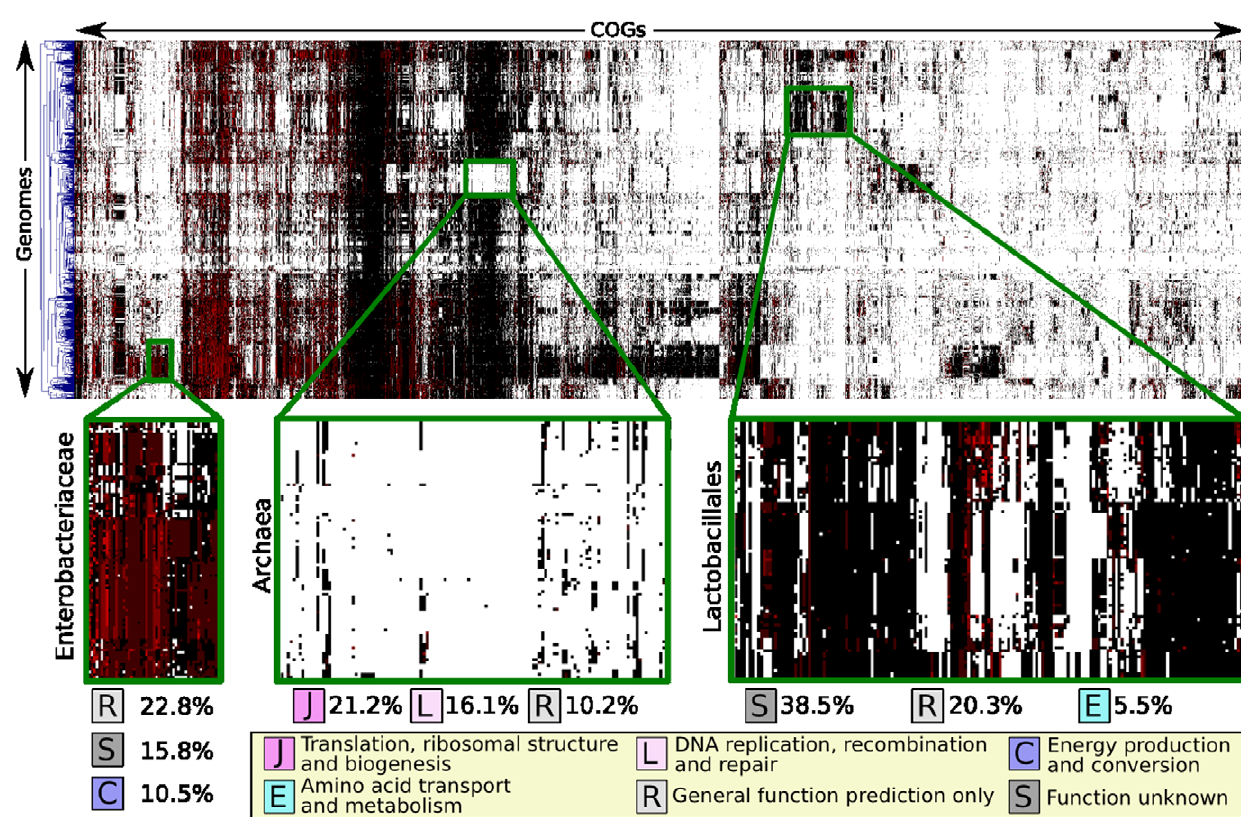
Figure 2. Hierarchical clustering of organisms based on the COG gene families present in their genomes. Heat maps represent individual COG orthologous gene family abundances (columns) for each taxon (rows); absent gene families are white, single copy families are black, and multicopy families red. The resulting functional phylogeny represents a type of phylogenetic profiling and clearly highlights functional characteristics specific to groups of organisms independent of their evolutionary relatedness. In many cases, evolutionary and functional similarities are highly correlated; three representative clusters are enlarged in green boxes and the three most abundant COGs for each cluster are reported. Note that the absence of the bacterial ribosome and DNA maintenance machinery from the Archaea is readily apparent from such data, and that the Enterobacteriaceae and Lactobacillales both include striking large clusters of strongly conserved uncharacterized genes.